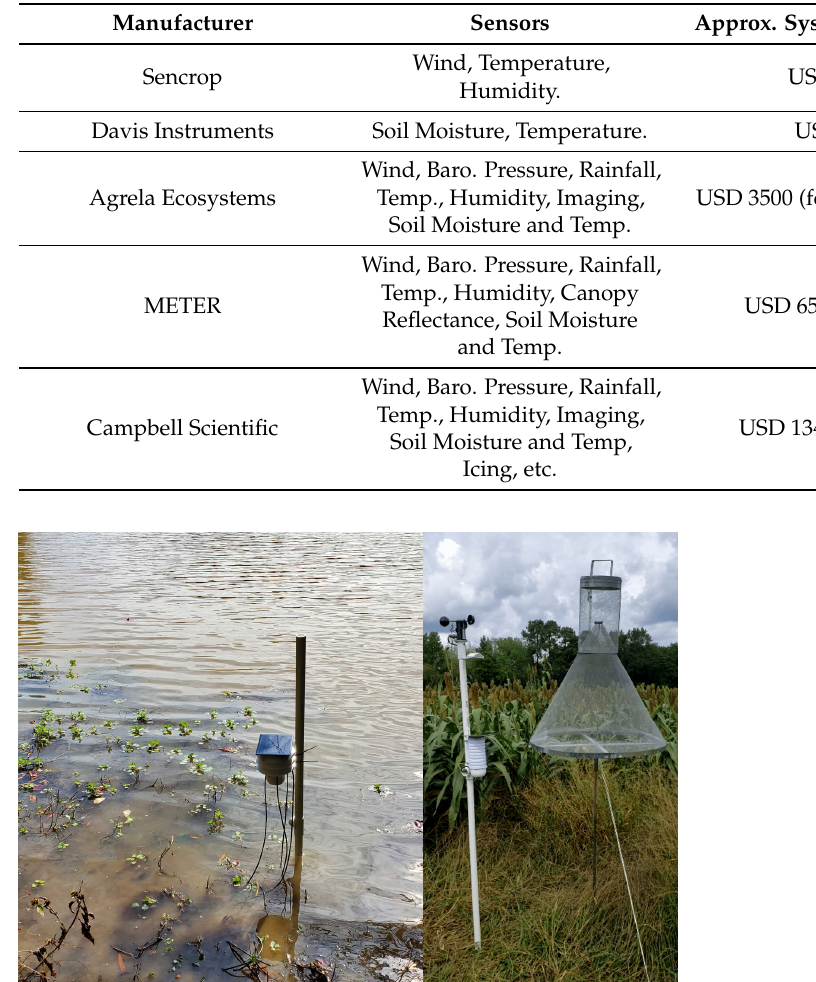
Table 1. A comparison of commercially available sensor platforms.